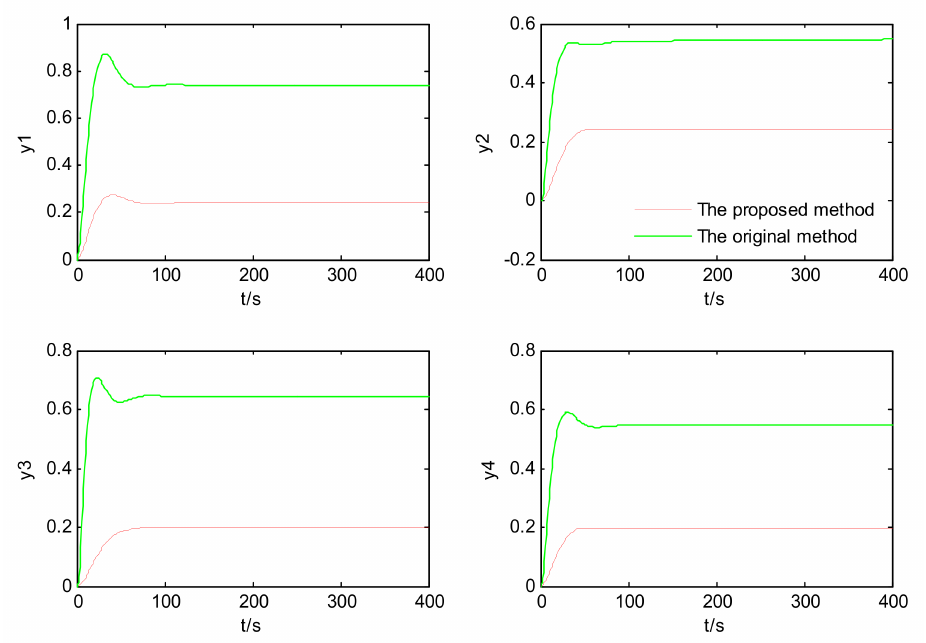
Figure 7. Set-point responses of r 4 = 1 and r 2 = r 3 = r 4 =